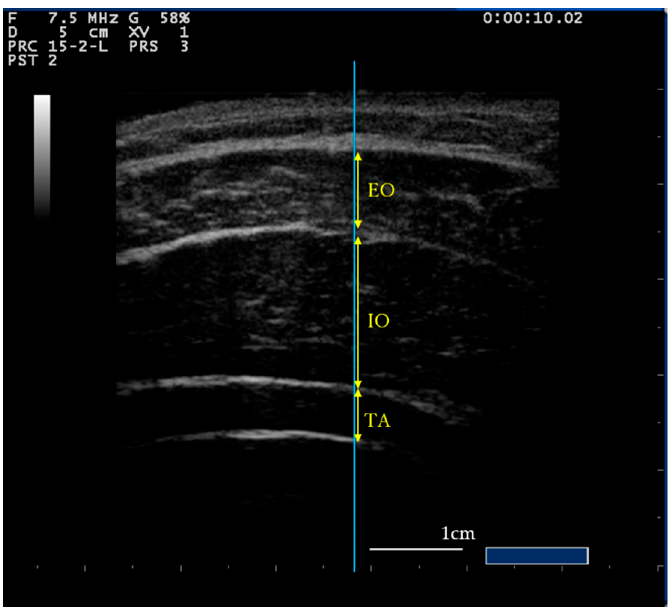
Figure 1. Ultrasound image of the flank. The Blue line passing through the middle of the image. The yellow arrow indicates the measurement site of each muscle. The white line shows the 1-cm scale bar. During the measurement, the position of the probe was kept constant. EO, External oblique muscle; IO, Internal oblique muscle; TA, Transverse abdominal muscle.